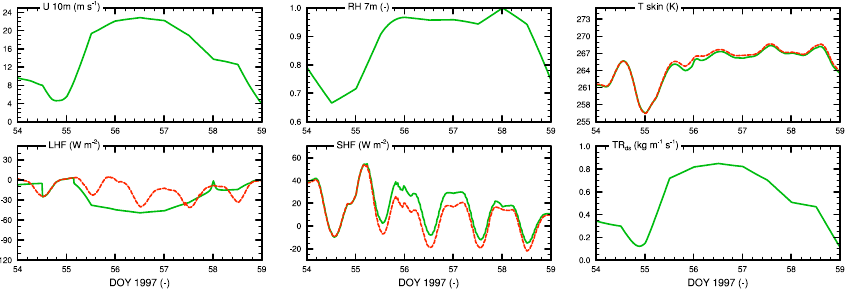
Fig. 11. Time evolution of 10m wind speed, 7m relative humidity, skin temperature, latent heat flux, sensible heat flux and TR ds as modelled by RACMO2-SCM, of DOY 54–59 in the year 1997 (23–28 February). The green lines represent the simulation with snowdrift, the red line is the NODRIFT simulation.